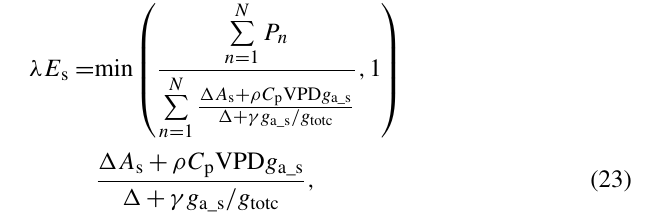
Table 2. Combinations of the six existing soil evaporation algo- rithms with the P-LSH vegetation evapotranspiration and water evaporation